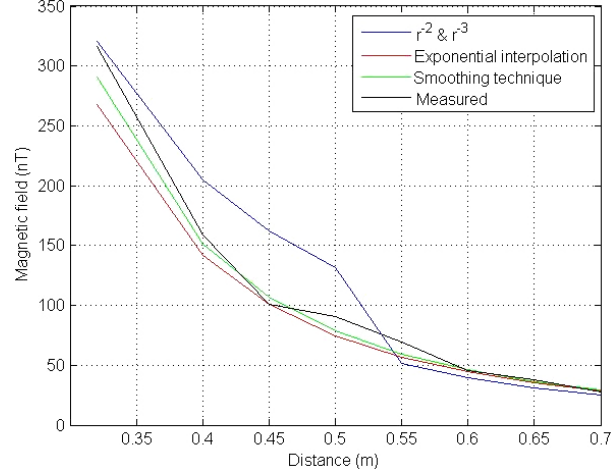
Figure 11. Magnetic field’s prediction with respect to the distance with fixed magnetometers’ location at 26 and 45cm, using several techniques (mobile phone used as